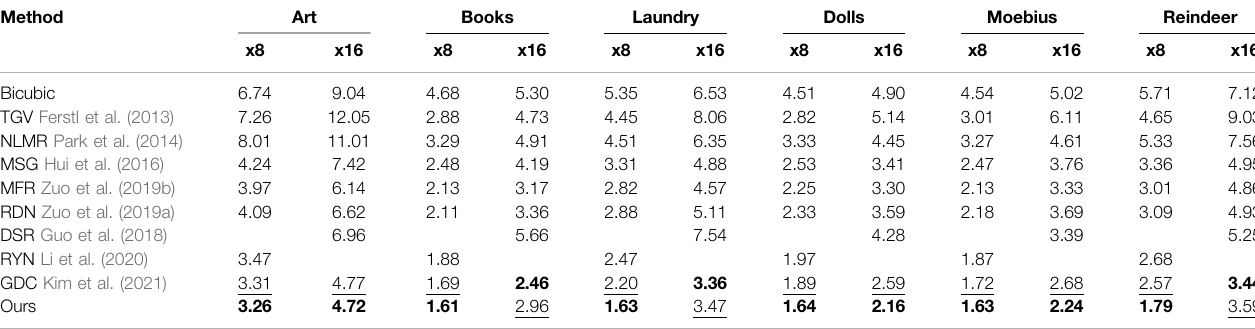
TABLE 3 | Quantitative comparisons on the noisy middlebury dataset in terms of RMSE values for scaling factors 4 and 8. Method